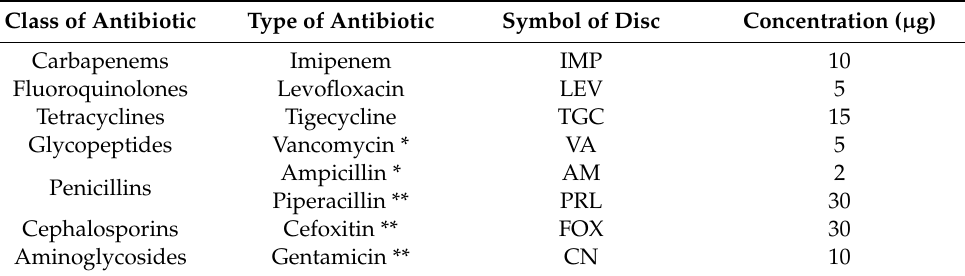
Table 2. Characteristic of used